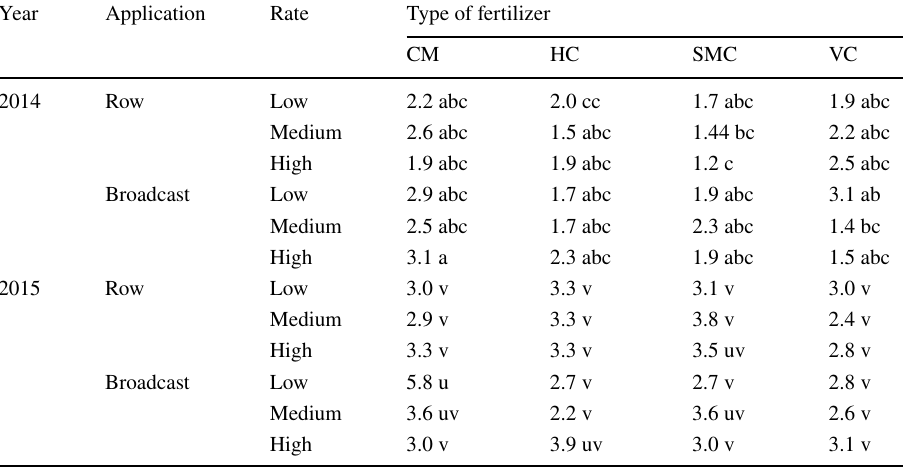
Means followed by different letters are significantly different ( p ≤ 0.05, Tukey test) CM Cow Manure, HC Household Compost, SMC Spent Mushroom Compost,